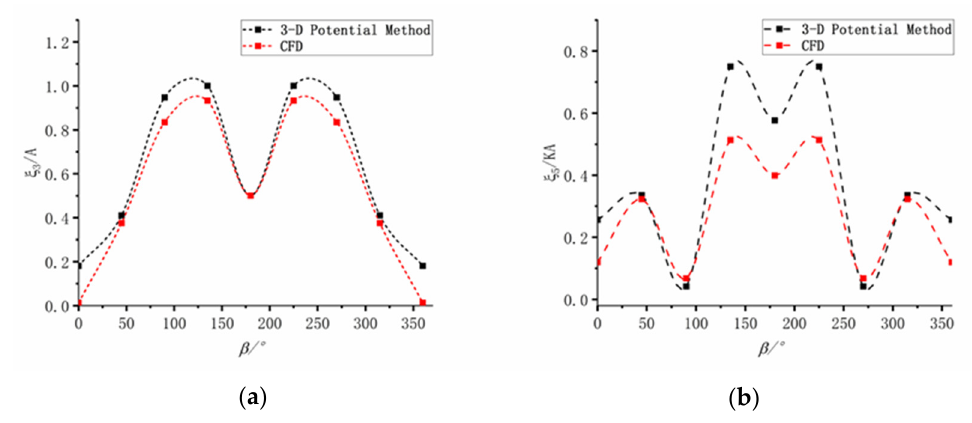
Figure 17. RAOs of “Yukun” hull at V = 16.7 knots. ( a ) Heave. ( b ) Pitch.